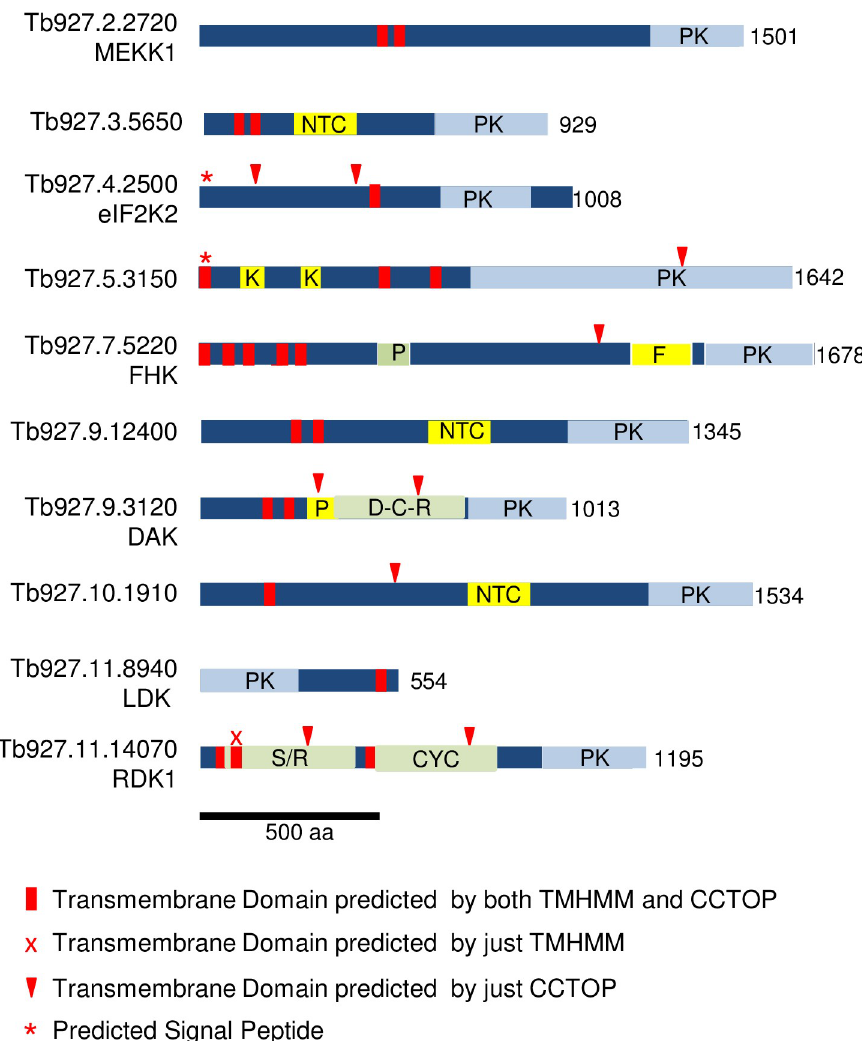
Fig 1. Schematics of T . brucei protein kinases predicted to bear transmembrane domains. TMDs predicted by both TMHMM and CCTOP are marked with red bars (one predicted by TMHMM only is marked with a red X); additional TMDs predicted by CCTOP are marked by red arrowheads. Predicted signal sequences are indicated by a red asterisk. Light blue regions are ePK Pfam domains. Yellow bars depict other domains: PAS motif (P), forkhead associated domain (F), nucleotide cyclase-like domain (NTC), Kelch propeller blade (K). Light green bars demarcate regions with predicted structural similarity to known structures revealed by HHpred. Bacterial DHp, catalytic, and receiver domains characteristic of histidine kinases (D-C-R) in Tb927.9.3120, as well as bacterial sensor/receptor domains (S/R) and adenylyl/guanylyl cyclases (AGC) in RDK1, exhibited probabilities > 95% (see Fig 2 and S2 Fig for details). The PAS-like domain in FHK was detected with > 90% probability. Length of the predicted protein in amino acids is indicated.